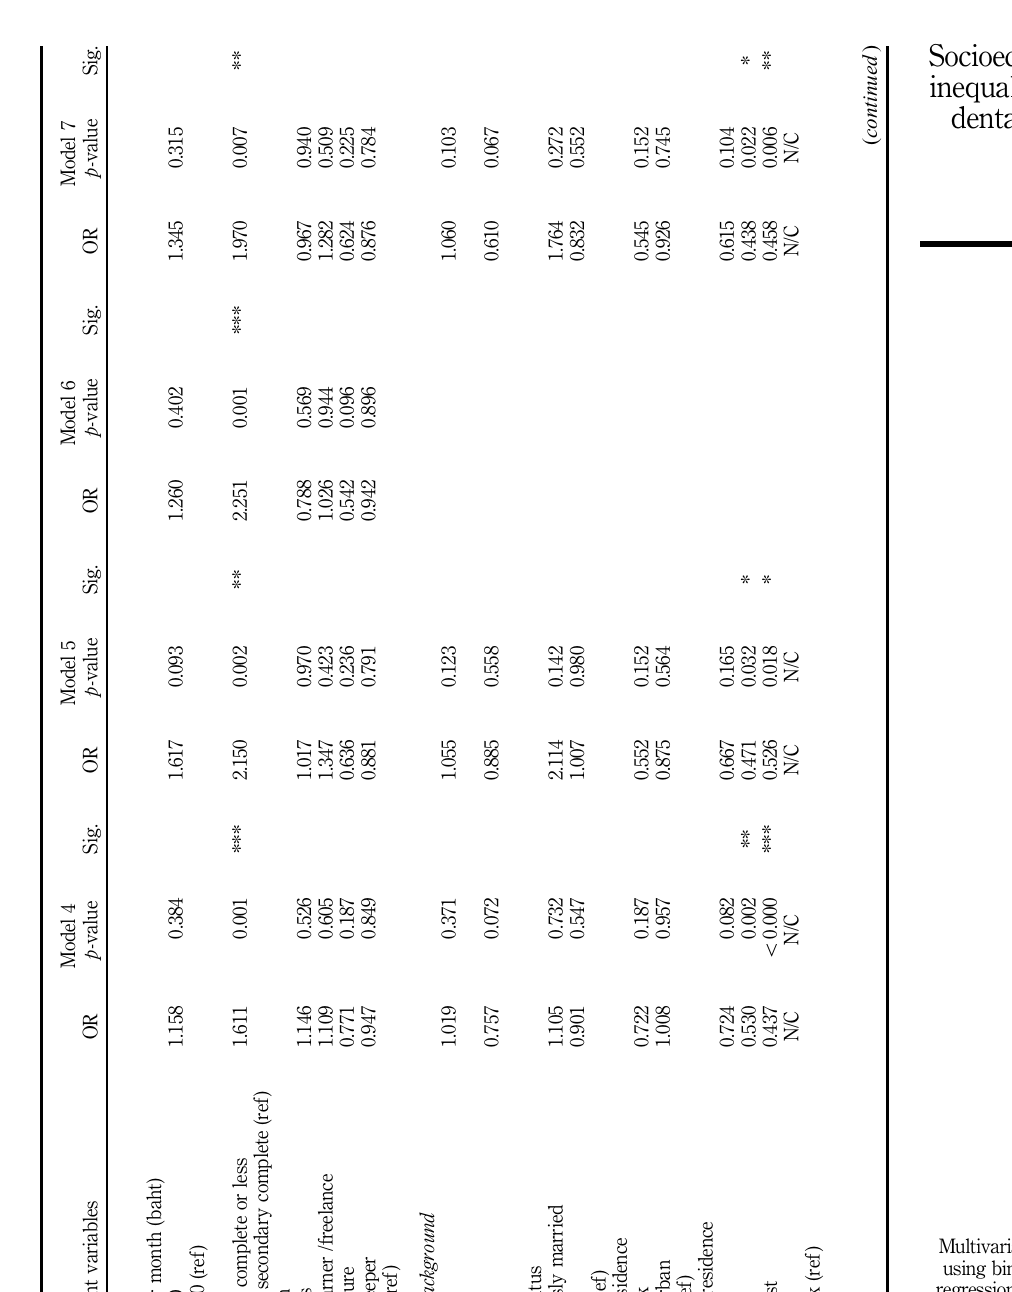
Table IV. Multivariate